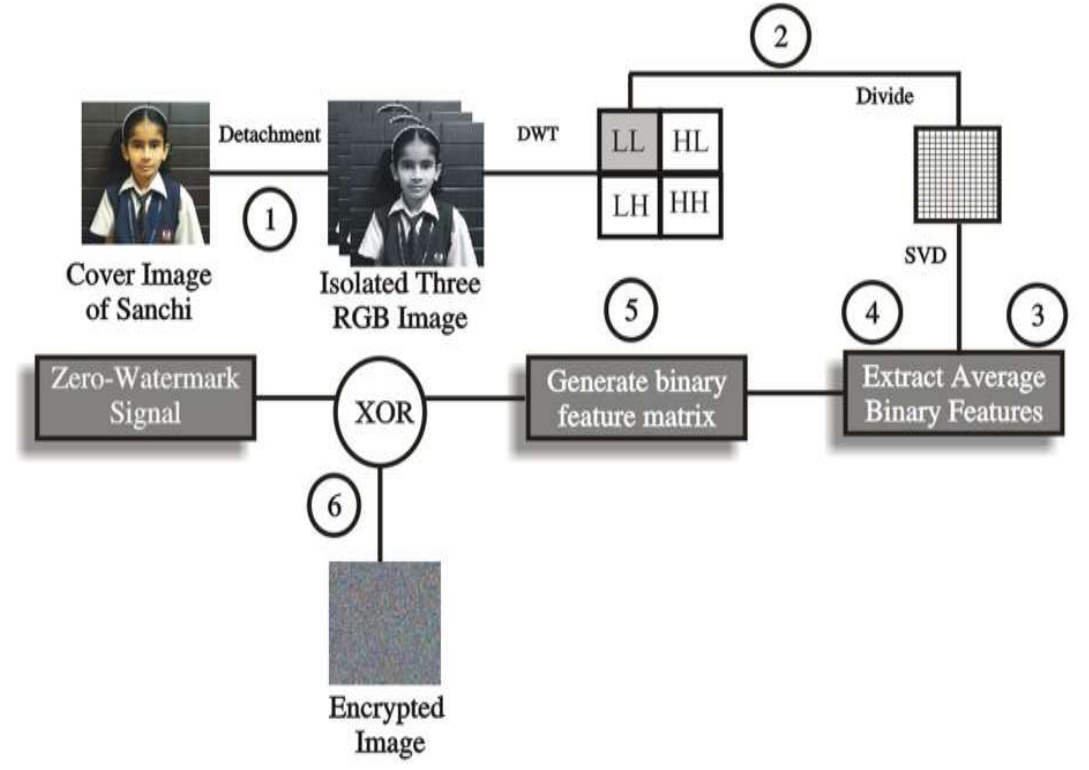
Figure 3. Block Diagram of Watermark Detection